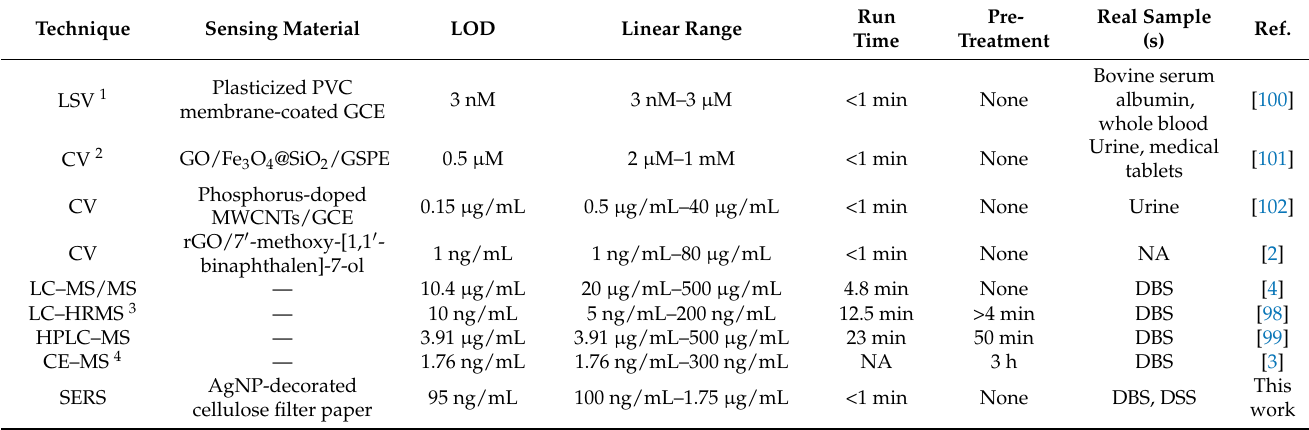
Table 4. Performance and comparison of AMT detection